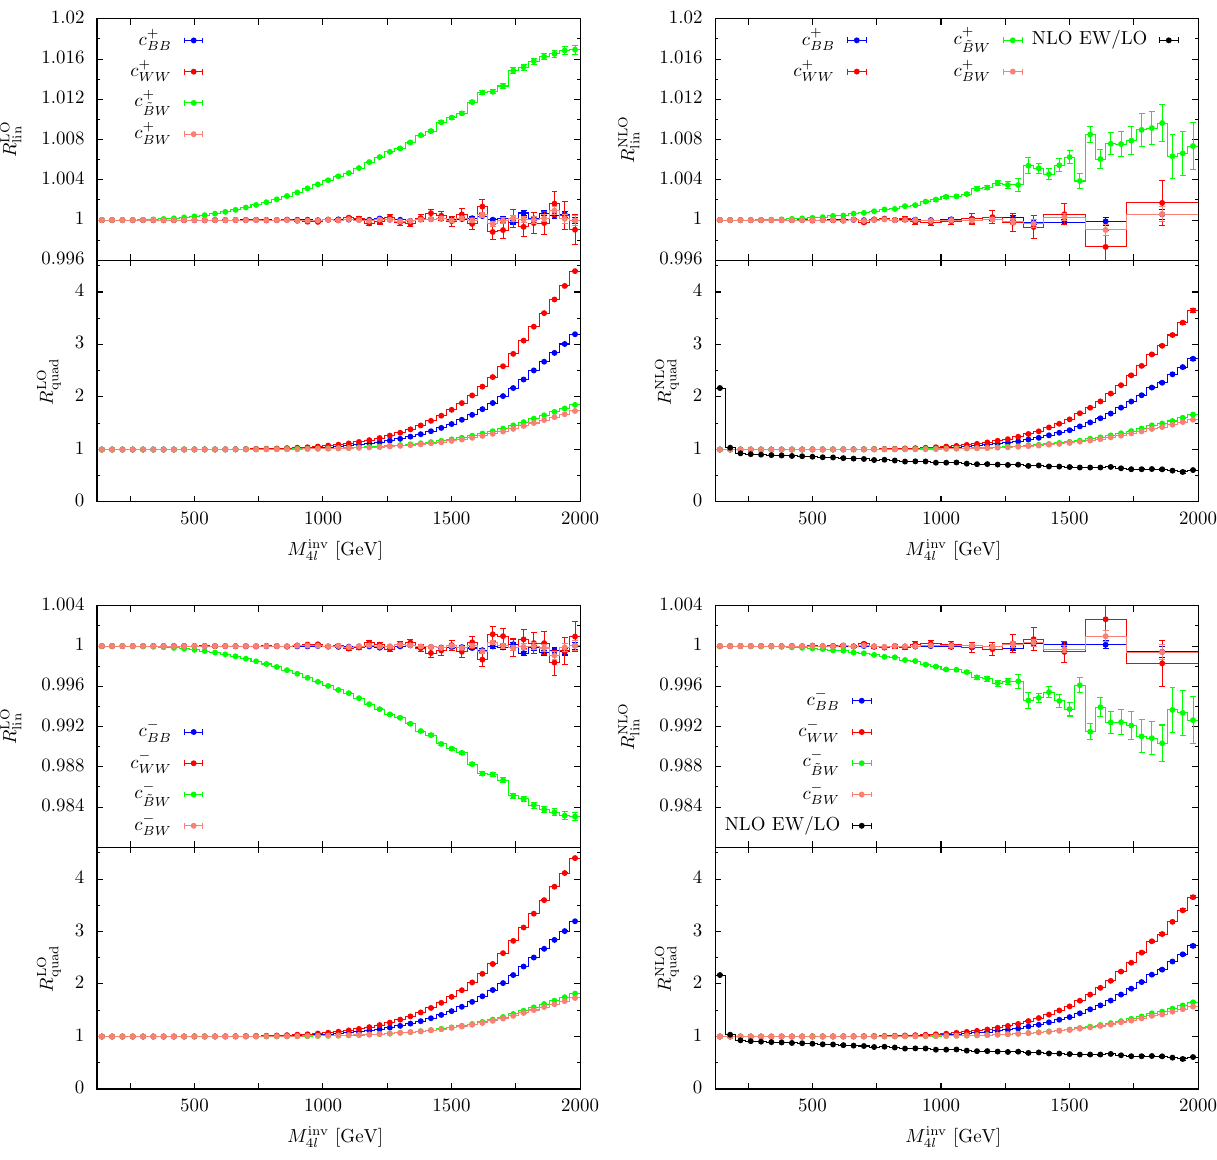
√ s = 13TeV under the event